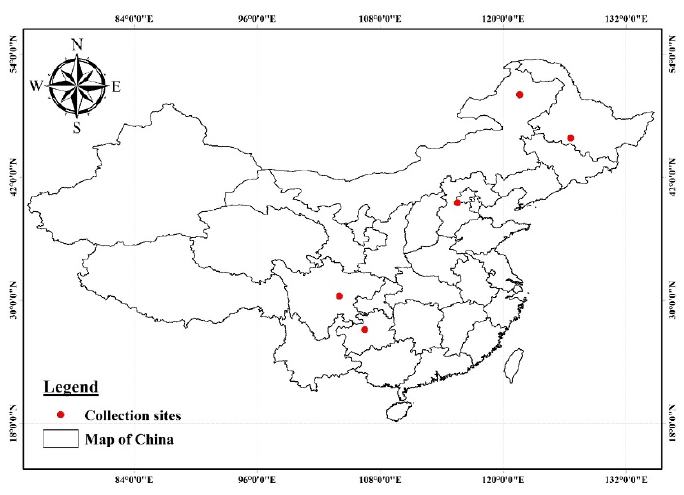
Figure 2. Map of China; red dots indicate collection sites of the Asian spongy moth ( L. dispar asiatica ) egg masses.